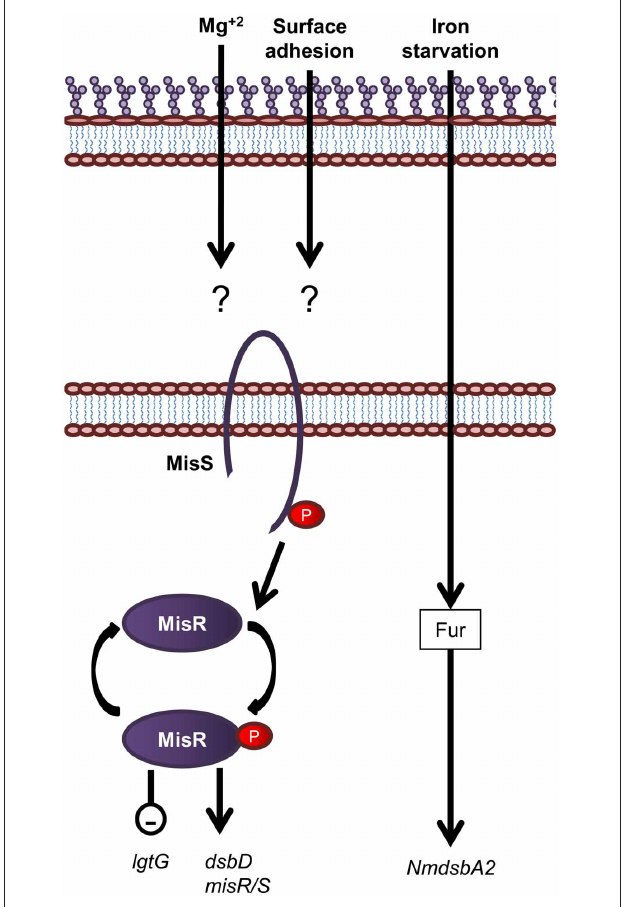
FIGURE 7 | Overview of regulatory systems involved in LPS biogenesis and periplasmic protein folding in N. meningitidis. The sensor histidine kinase and cognate response regulator protein of the MisS/R two component system is shown. Expression of the oxidoreductase gene NmdsbA2 is regulated by an unknown mechanism in response to iron. Genes are in black text, lower case and italicized while proteins are in sentence case. Up-regulation of downstream processes is indicated by arrows while down-regulation is indicated by a minus sign within a circle.